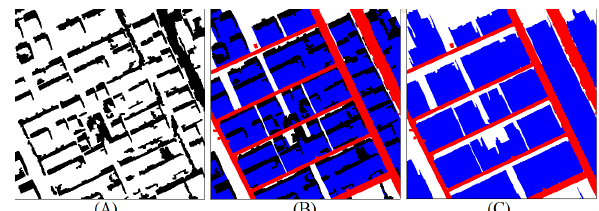
Figure 9. A. Reconstruct shadow components based on components with known azimuth, B. Building blocks